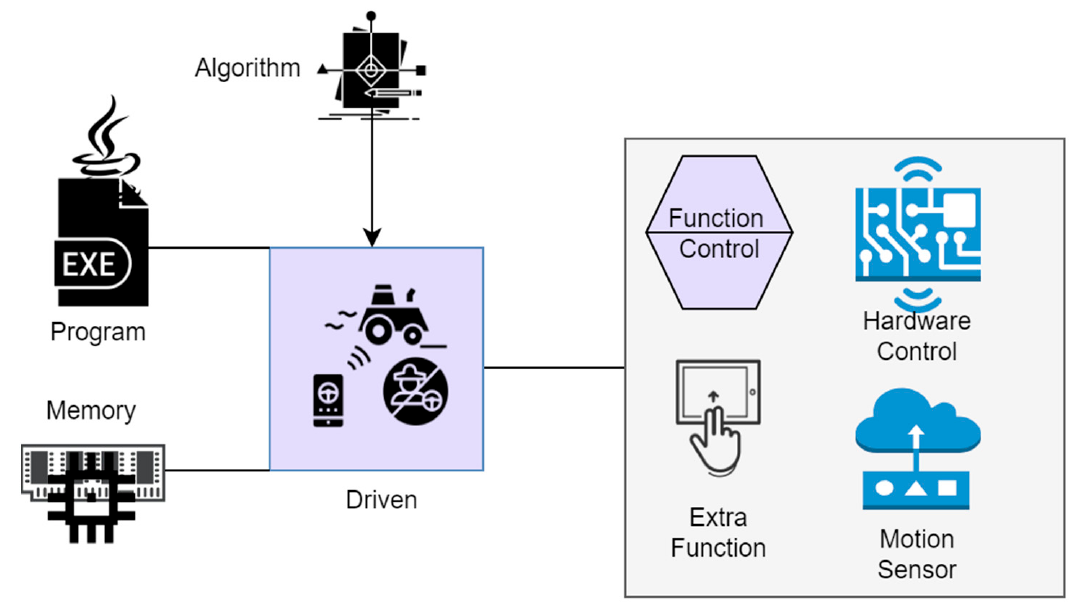
Figure 4. Modified mechanical design of PA.